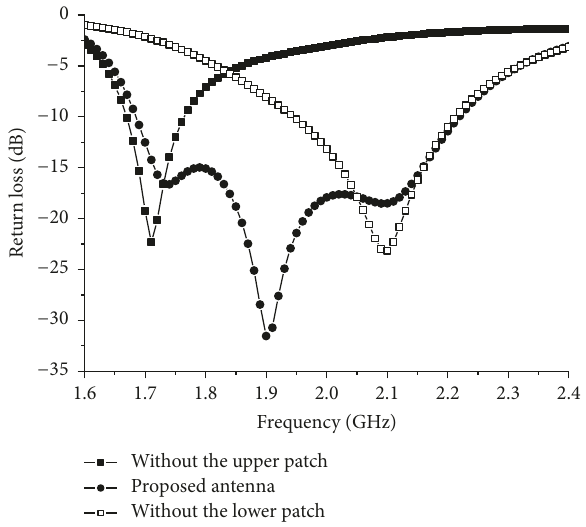
Figure 2: Simulated return loss against frequencies for the antenna without the loaded patches compared with the proposed antenna.